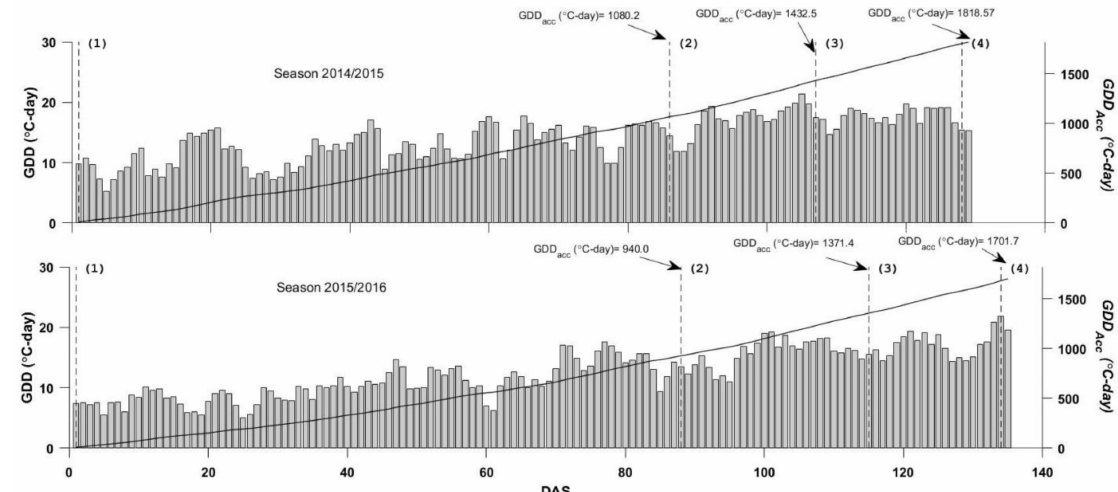
Figure 7. Daily growing degree-days ( GDD , vertical bars) and cumulative growing degree-days ( GDD Acc , in 2014/2015 and 2015/2016 seasons. DAS is days after sowing. Vertical thin lines indicate (1) sowing, (2) grain filling stage, (3) physiological maturity stage, and (4) harvest time. Sowing in the 2014/2015 season was on 5 October 2014; and sowing in the 2015/2016 season was on 20 September